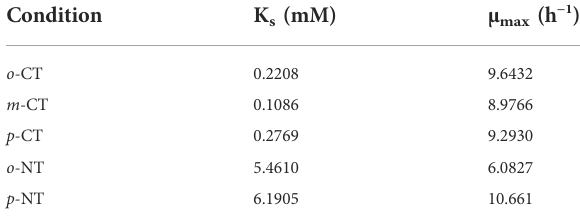
CTs showed signi fi cantly higher “ μ ” than those exposed to the inducer NTs. For example, SBRs of 7.99 h − 1 and 1.14 h − 1 were observed at 1 mM of p -CT and o -NT exposure, respectively (Figure 4). Under the tested concentration range, the observed SBR of KG1206 was in the range of 2.995 – 8.514, 4.268 – 8.464, and 2.452 – 7.980 h − 1 for o -, m -, and p -CT mM, respectively; very low bioluminescence activity ( < 500 RLU) was observed for NTs exposure and SBRs of 0 – 2.477 and 0.233 – 5.345 h − 1 for o - and p -NT under tested conditions, respectively (Table 1). The K s measures the af fi nity for each substrate, and a low K s value indicates a high af fi nity for substrate compared to a high K s value. Based on the “ μ ” values calculated from the bioluminescence activity at various initial inducer concentrations, the K s and maximum μ ( μ max ) were calculated using the Lineweaver – Bulk equation (Table 1). Among the inducers tested, m -CT exposure showed the highest bioluminescence activity with the lowest K s (equal to 0.1086 mM; corresponding to the highest af fi nity), whereas p -NT exposure showed the lowest bioluminescence activity with the highest K s value (6.191 mM). The K s values were in the following order: m -CT (0.1086 mM) > o -CT